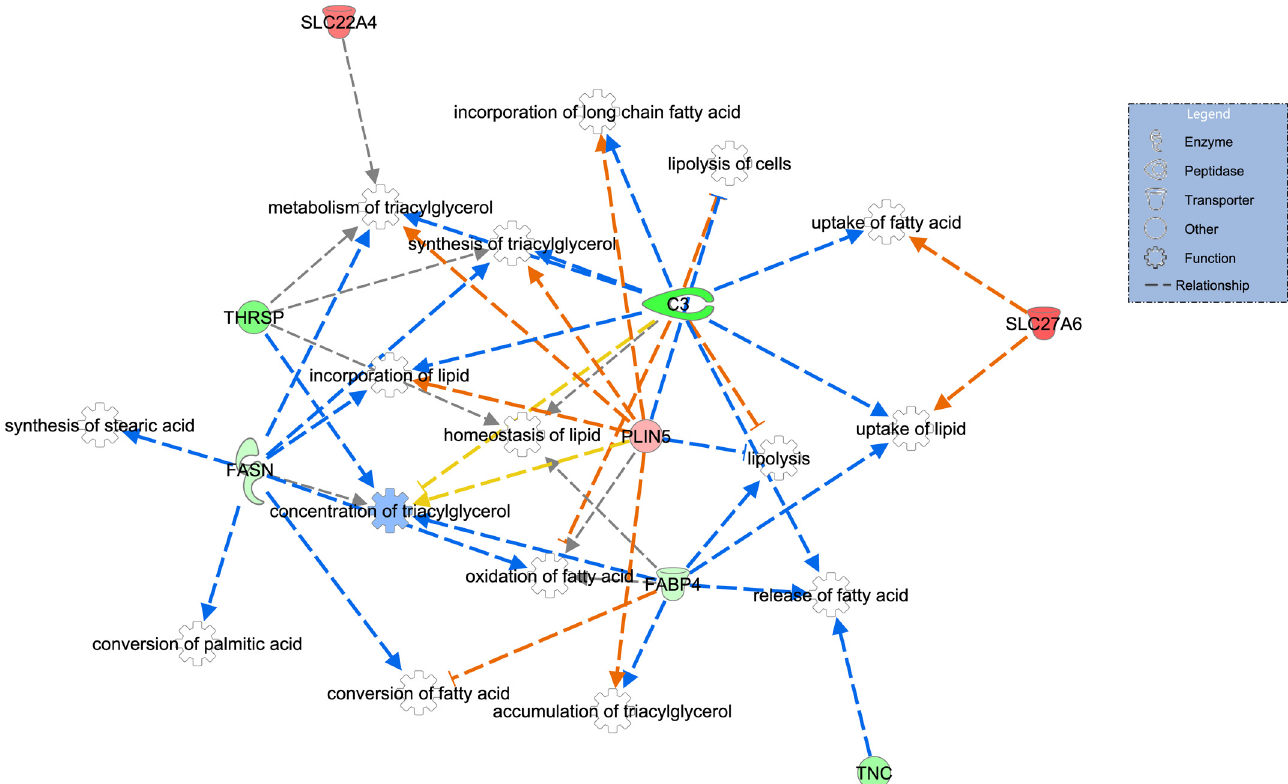
Fig 2. Lipid metabolism related network of differentially expressed genes between high and low iron content in the Nelore steers Longissimus dorsi muscle. Genes in green and red are down- and up-regulated in the LowFe group, respectively. Color intensity refers to fold change estimates. Dotted arrows represent indirect interactions, and orange, blue, gray, and yellow colors denote activation, inhibition, unpredicted effect, and inconsistent effect, respectively. Reprinted from [QIAGEN ’ s Ingenuity 1 Pathways Analysis] under a CC BY license, with permission from QIAGEN Silicon Valley, original copyright [200 – 2015